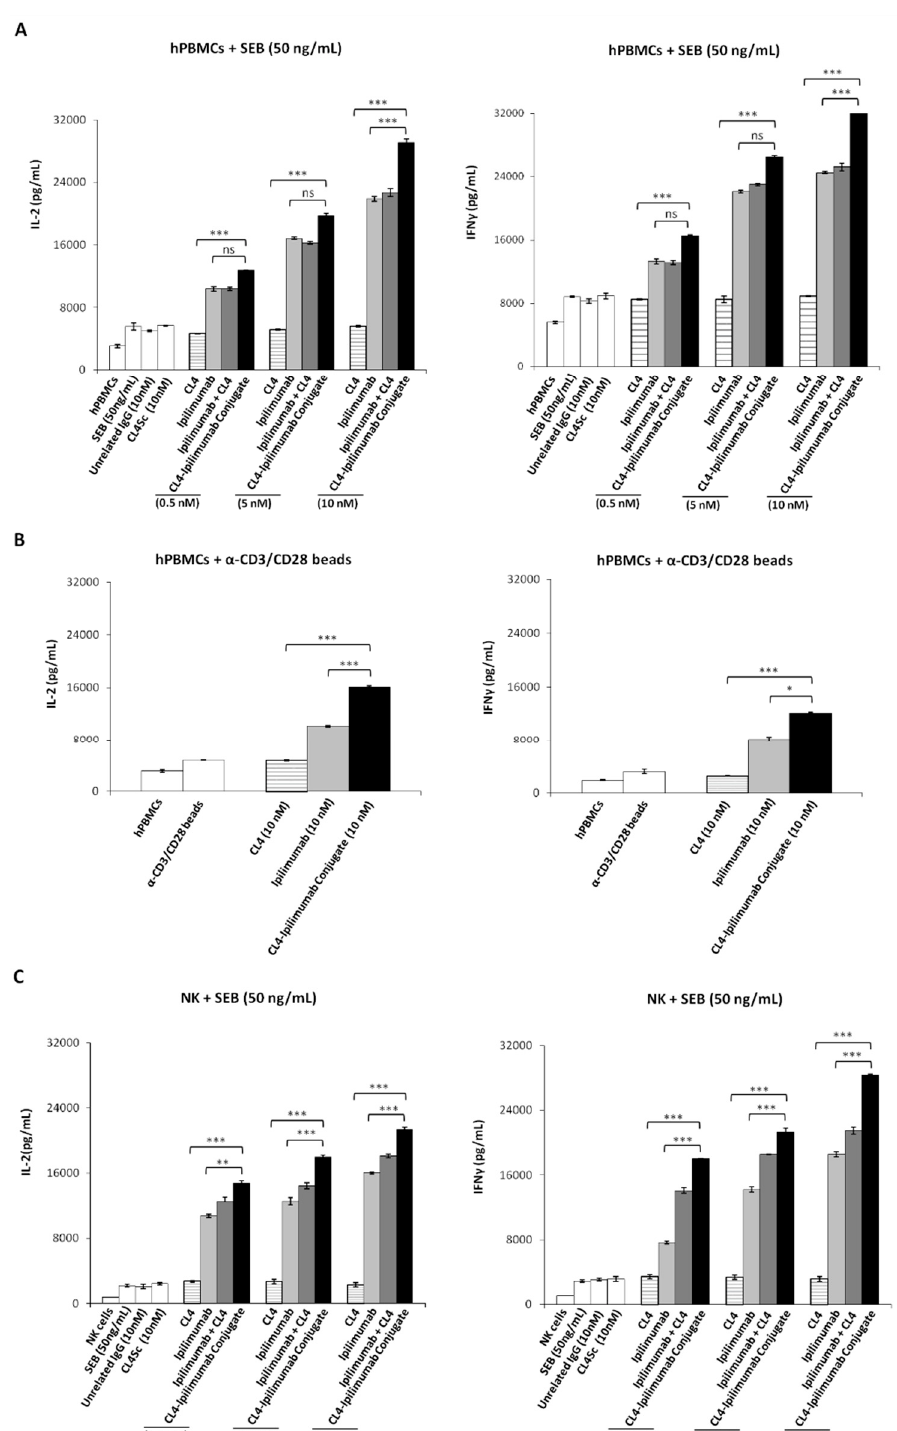
Figure 4. Effects of CL4-ipilimumab conjugate on cytokines secretion by different populations of hPBMCs. Levels of IL-2 and IFN- γ secreted from hPBMCs stimulated with SEB ( A ) or CD3 + T cells (PBMCs activated with α -CD3/CD28 beads) ( B ), or isolated NK cells treated wih SEB ( C ), in the absence or in the presence of CL4-ipilimumab conjugate (black bars), unconjugated CL4 (striped bars), ipilimumab (light grey bars), or their combination (dark grey bars) at the indicated concentrations for 66 hours. Untreated or stimulated hPBMCs in the absence or in the presence of CL4Sc or unrelated IgG mAb were used as negative controls. Error bars depict means ± SD. p -values for the indicated compounds are: *** p ≤ 0,001; ** p < 0.01; * p < 0.05.